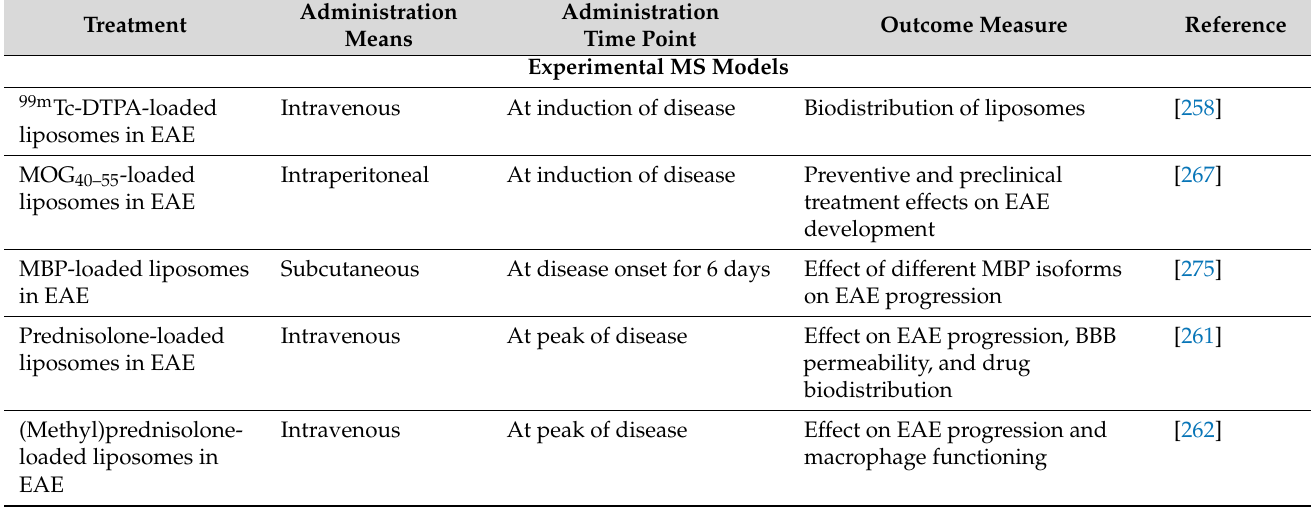
Figure 3. Strategies to deliver MS therapeutics that overcome the fibronectin-mediated inhibition of remyelination failure in the brain. Therapeutic compounds encapsulated in nanoparticles that contain a blood–brain barrier (BBB)-targeting ligand or carry a positive charge enter the brain via transcytosis through receptor-mediated transcytosis (RMT) or adsorptive-mediated transcytosis (AMT), respectively. Alternatively, in relapsing–remitting MS, surveilling monocytes may phagocy- tose nanoparticles and transport these across the compromised BBB during relapses. Furthermore, the identification of lesion-specific BBB alterations (i.e., upregulation of receptors at the BBB near lesions) would aid the targeting of lesion-directed medication. In the brain, lesion targeting of therapeutic-containing nanoparticles may be achieved by cell-specific ligands targeting receptors that are present on, e.g., oligodendrocyte lineage cells, or ligands targeting the altered, and therefore specific, environment in MS lesions. For example, targeting specific splice variants of fibronectin that are abundant in fibronectin aggregates can aid the cell- and lesion-specific delivery of the thera- peutic compound. This ‘two-step approach’ utilizes ligands that facilitate transcytosis across brain endothelium (BBB) and ligands that direct the delivery of therapeutics to MS lesions. Table 2. Nanoparticles used for treatment in experimental MS models and in MS